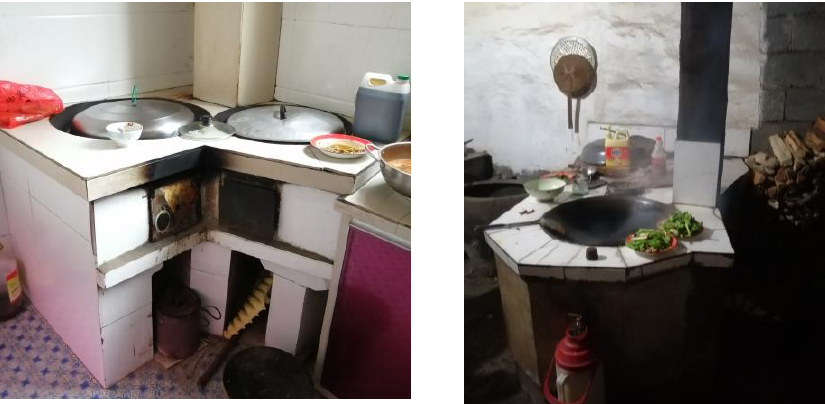
Figure 4. Photo of the present situation of cooking in southern Shaanxi.